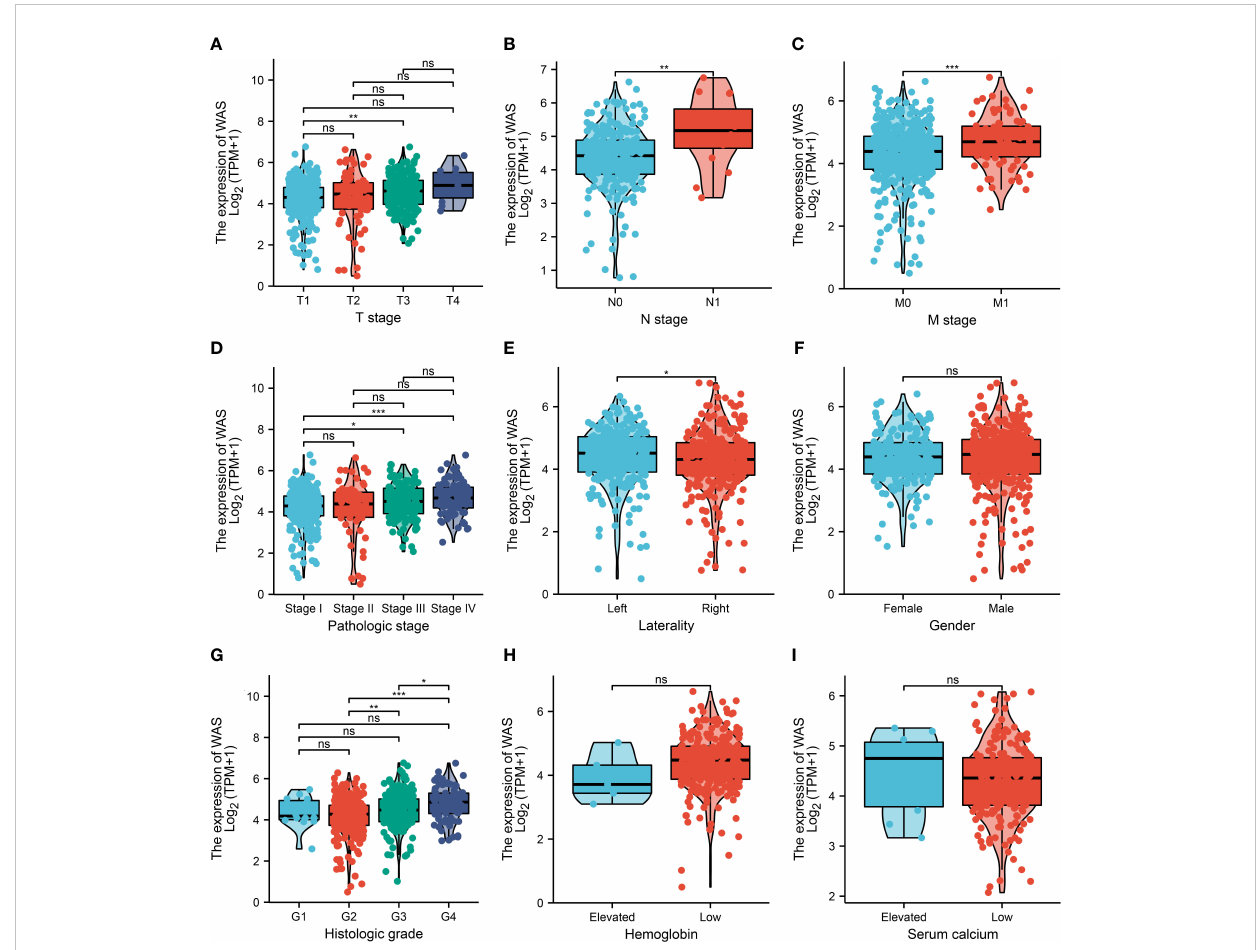
FIGURE 2 The relationship between WAS expression and clinicopathological features. Correlation analysses between WAS mRNA expression and T stage (A) , lymph node metastasis (B) , M stage (C) , pathological stage (D) , laterality (E) , gender (F) , histological grade (G) hemoglobin (H) and serum calcium (I) . (ns: no signi fi cance; * P < 0.05, ** P < 0.01, *** P <